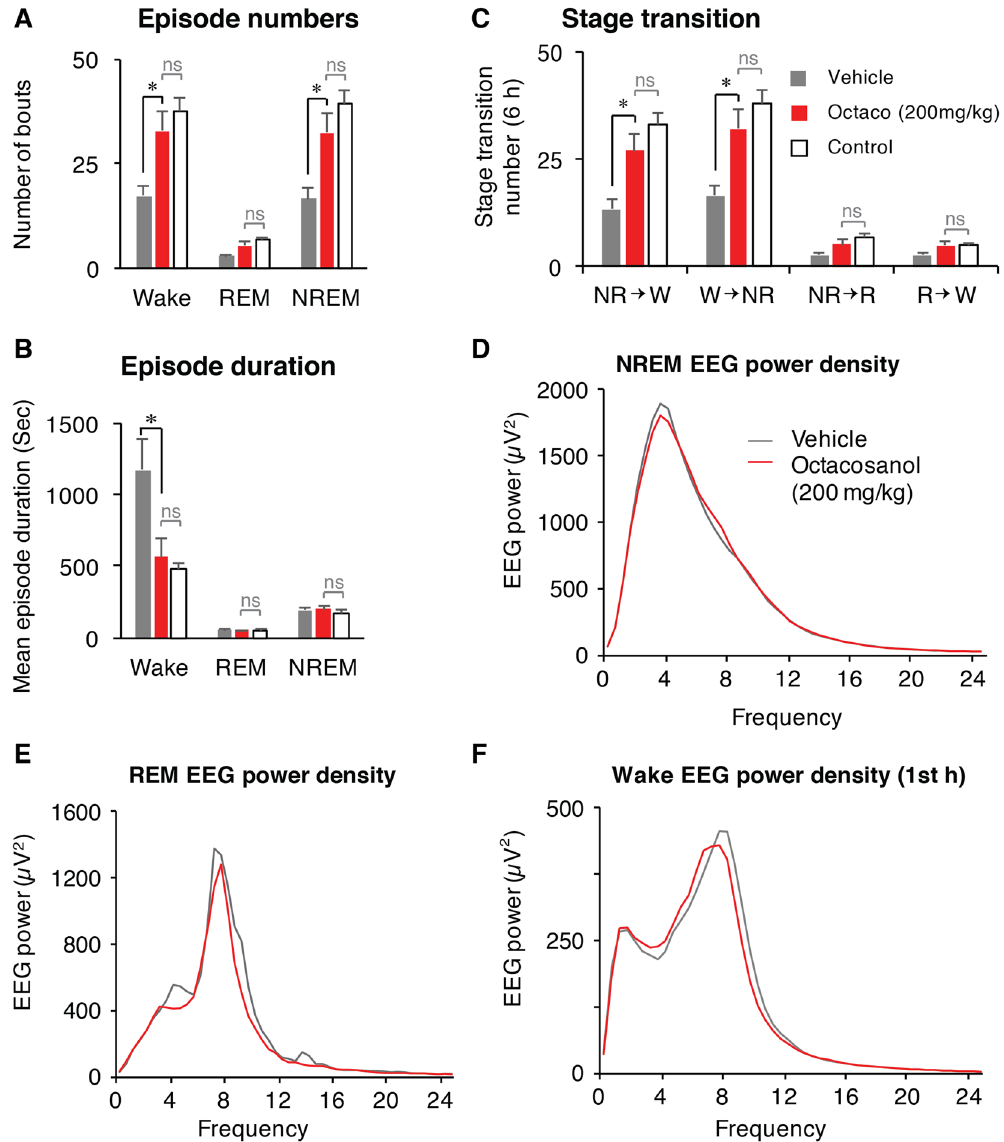
Figure 3. Changes in sleep architecture after octacosanol administration in mice. Graphs show qualitative analysis thus sleep architecture following p . o . administration of vehicle (gray bars), octacosanol (200 mg/kg; red bars), and control (open bars) during initial 6 h of dark phase. Graphs represent changes in number of episodes (bouts; A ), mean duration ( B ) of wake, REM, and NREM sleep. ( C ) Graph shows stage transition from NREM to wake (NR → W), wake to NREM (W → NR), NREM to REM (NR → R) and REM to wake (R → W). ( D – F ) Graph shows the EEG power density of NREM ( D ) and REM ( E ) sleep over 6 h dark phase, and wake ( F ) over 1 h following vehicle (gray line) and octacosanol (red line) administration in mice. Data presented as mean ± SEM; n = 5–8; * p ≤ 0.05, vs vehicle, by using one-way ANOVA followed by Scheffe post hoc